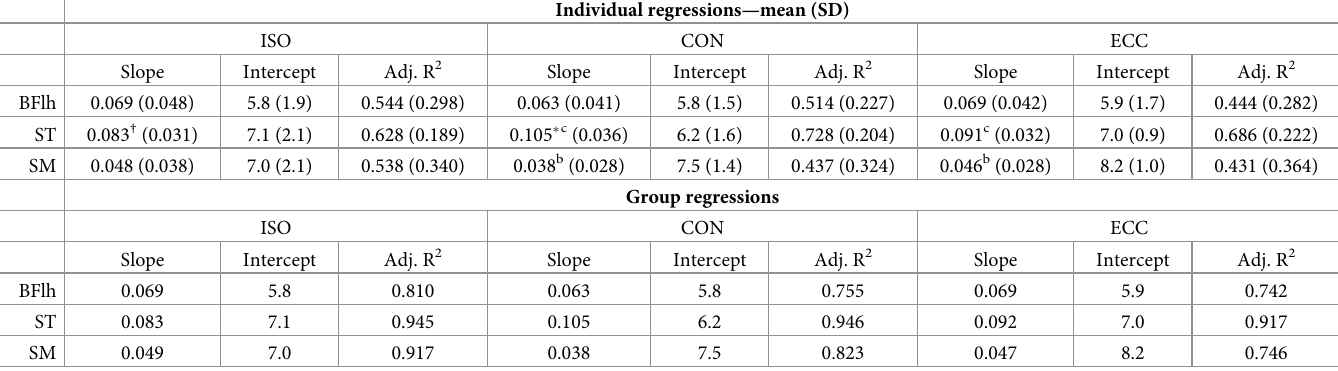
Table 1. Parameters of the linear regressions fitted to each participant’s duplicate SWV–torque data and to the duplicate group means for each muscle and contrac- tion type. Individual regressions—mean